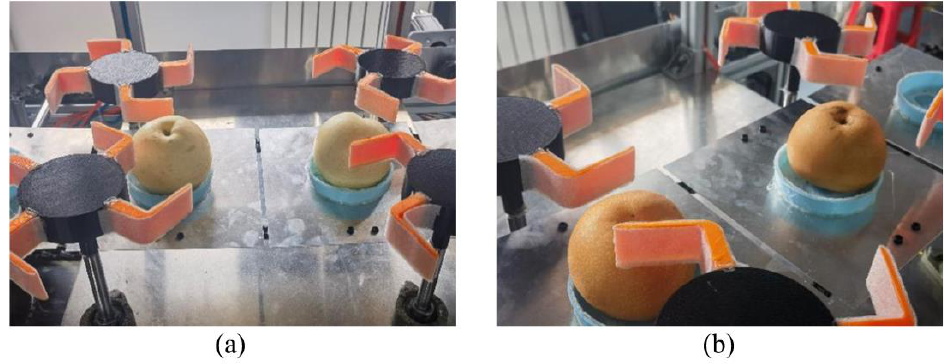
Figure 25. Packaging machine to work on other fruits: ( a ) Posture adjustment device to work on crown pear; ( b ) Posture adjustment device to work on Akizuki pear.